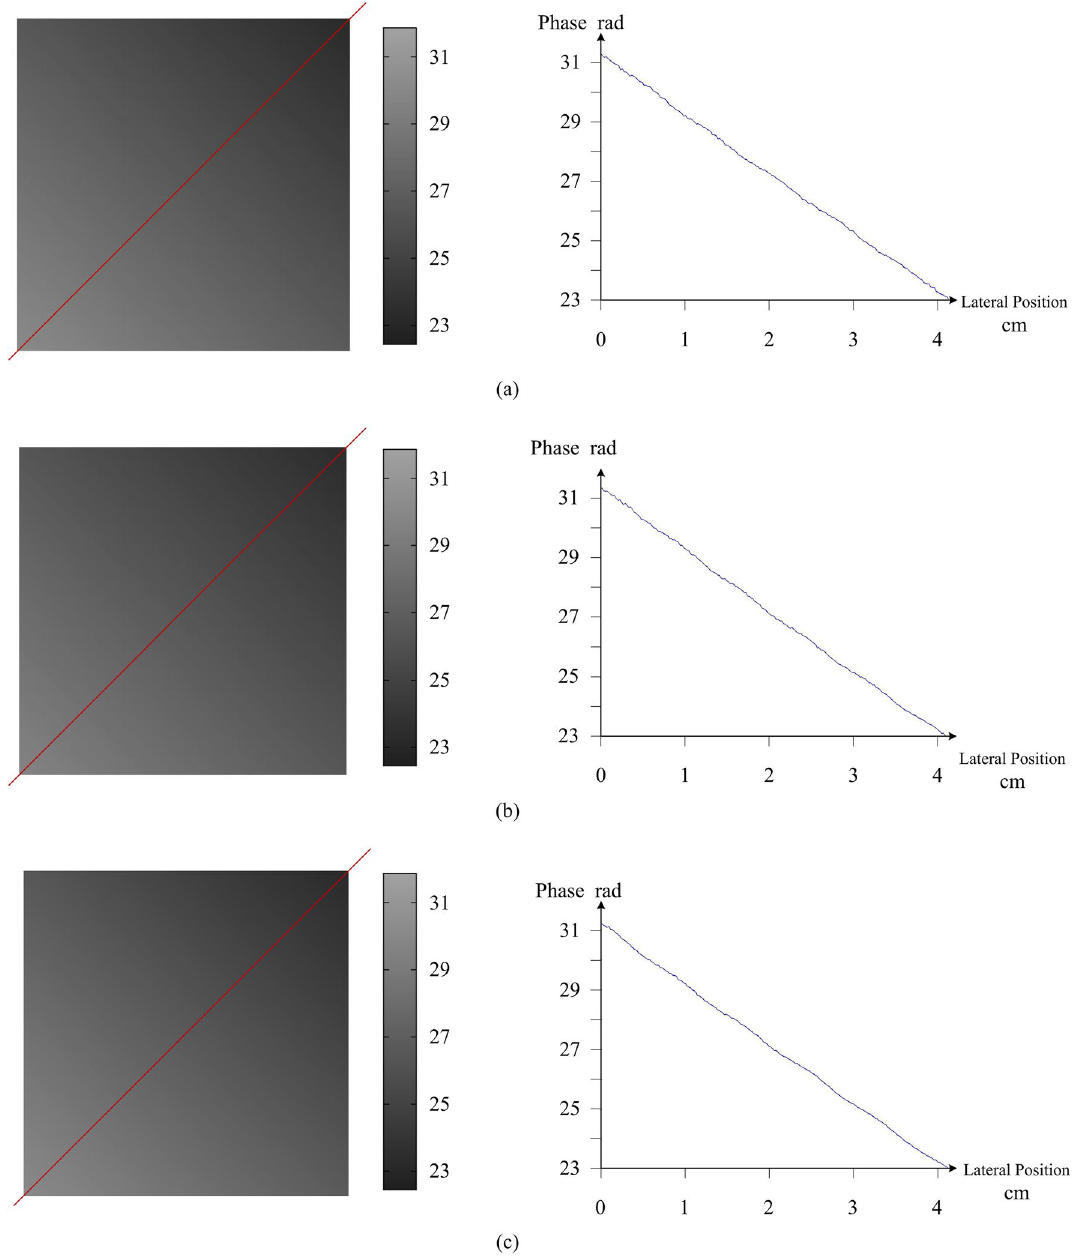
Figure 6. The cross section of phase map in the measurement experiment of the same plane. ( a ) obtained by Zhan Song’s method. ( b ) obtained by Rosario’s method. ( c ) obtained by Proposed method.